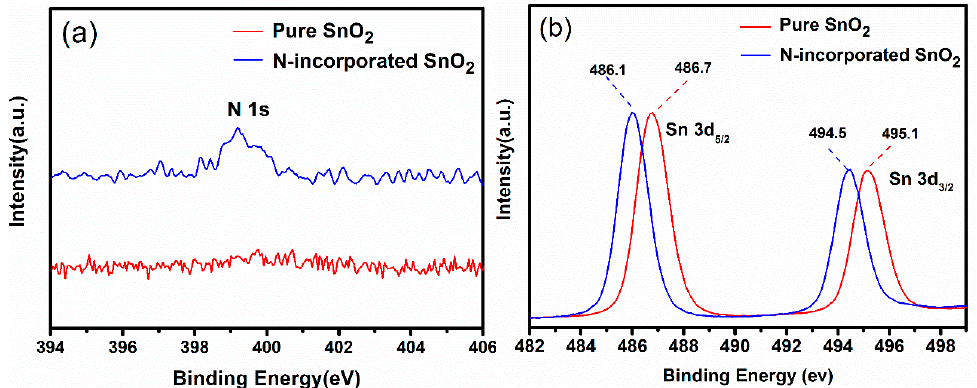
Figure 6. X-ray photoelectron spectroscopy XPS spectrum of ( a ) N 1s and ( b ) Sn 3d of N-incorporated SnO 2 and pure SnO 2 samples.